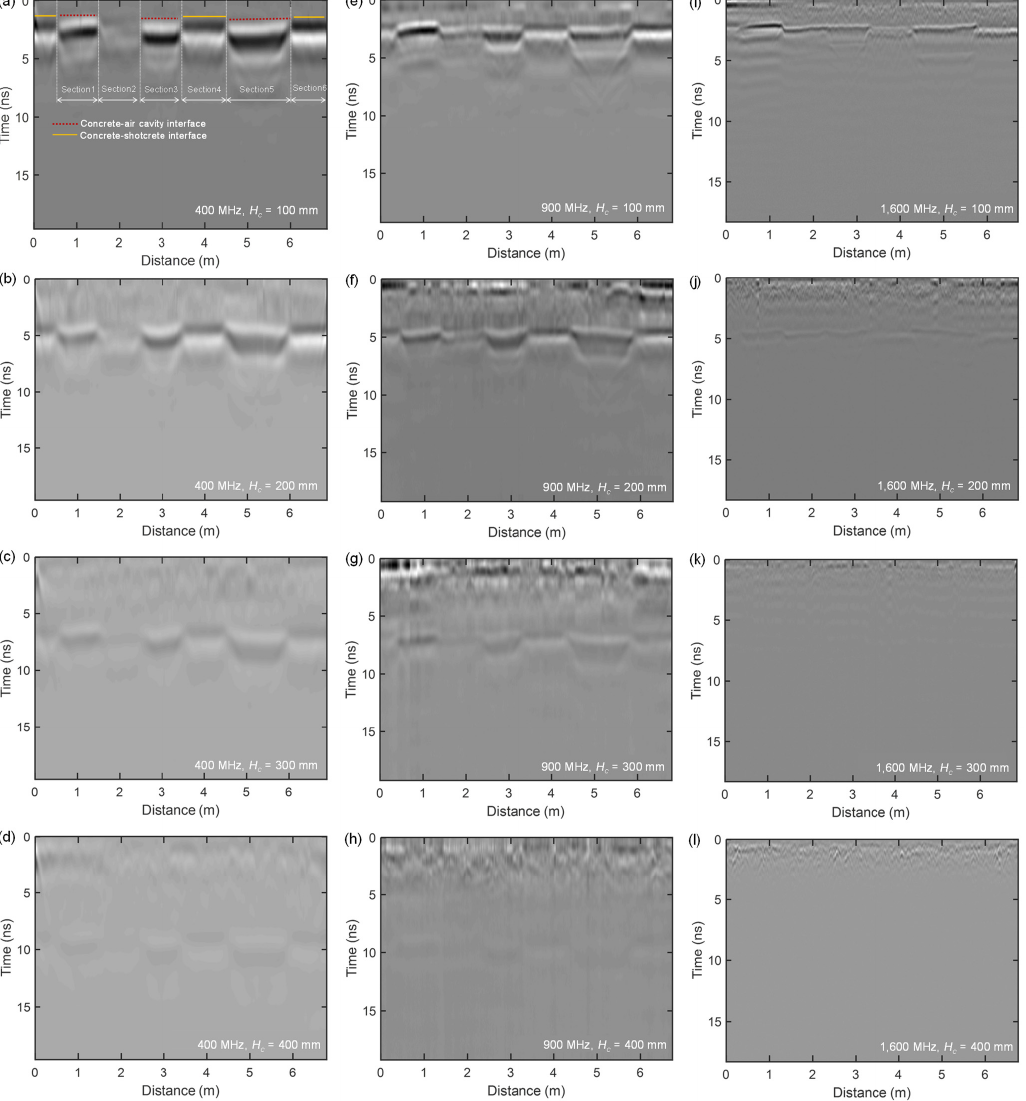
Figure 9. GPR B-scan radargrams measured on the surface of concrete with various thicknesses, H c , (100 mm, 200 mm, 300 mm, and 400 mm from top to bottom rows) in the concrete model specimen in this study using the three GPR antennas (400 MHz, 900 MHz, and 1600 MHz, from left to right columns): ( a – d ) using 400 MHz antenna, ( e – h ) using 900 MHz antenna, and ( i – l ) using 1600 MHz antenna on concrete with thicknesses H c = 100 mm, 200 mm, 300 mm, and 400 mm, respectively. First, the variation of concrete thickness can be clearly observed in the GPR radar- grams. Figures 9a–d, representing the GPR radargrams measured on the concrete with thicknesses of 100 mm~400 mm measured by the 400 MHz GPR antenna, show that the two-way travel time of the first EM reflections at the bottom of the concrete increases when increasing the thickness of the concrete. In practice, the thickness of the tunnel lin-